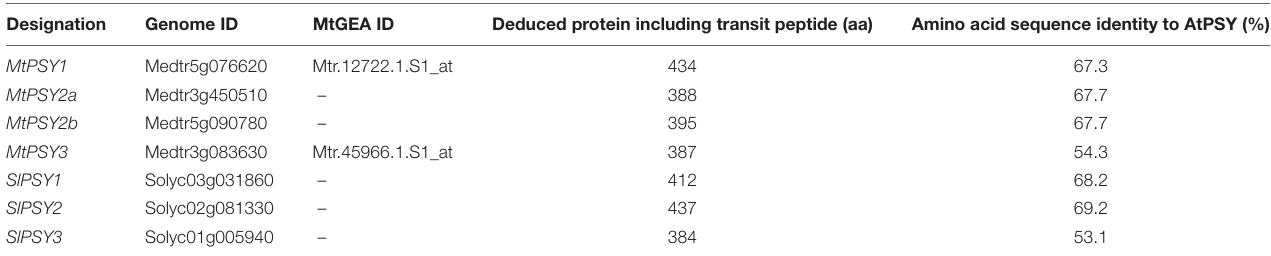
TABLE 1 | Designations and features of PSY isogenes from M. truncatula ( Mt ) and S. lycopersicum ( Sl